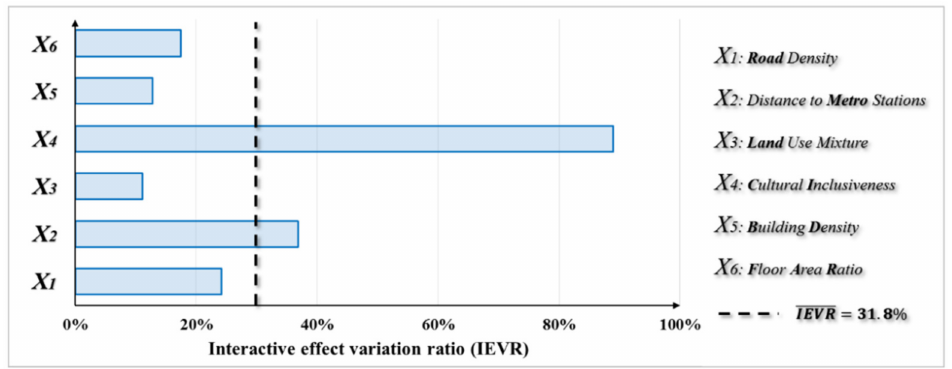
Figure 9. Interactive effect variation ratio ( IEVR ) of